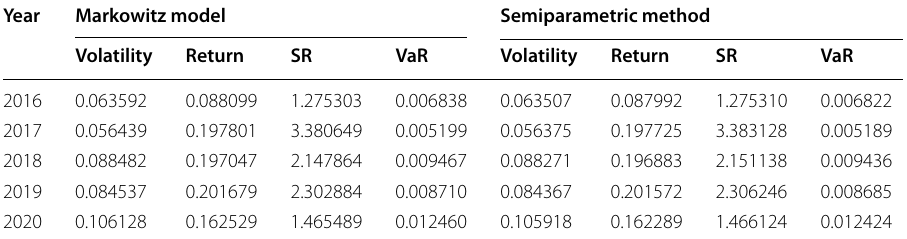
2020. Figure 2 depicts the portfolio value of the semiparametric model with CVaR and S&P 500.